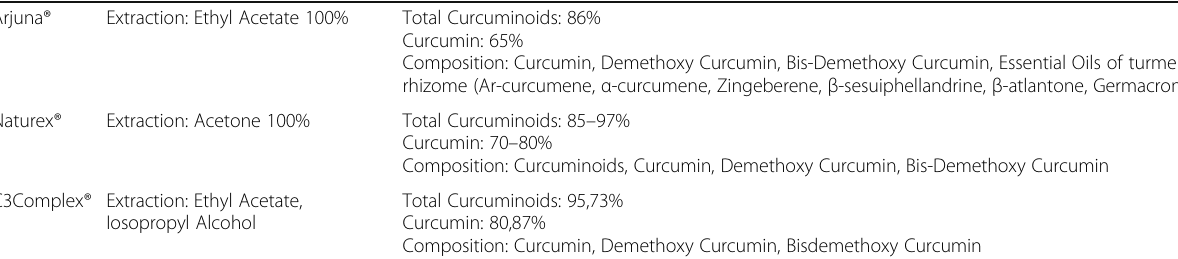
Table 1 Products Specification